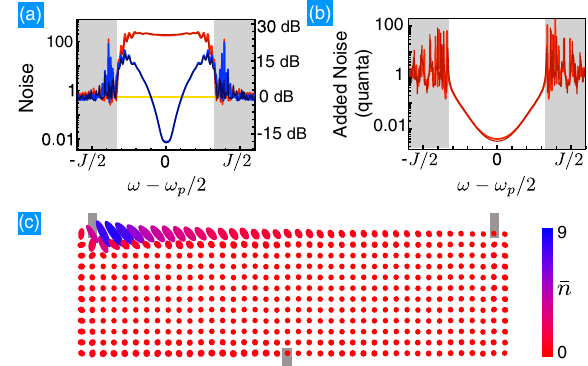
FIG. 4. Quantum stationary state and noise properties of the topological amplifier. (a) Noise spectral densities for both the amplified (red) and squeezed (blue) quadratures of the field leaving the output waveguide as a function of frequency, cf. Eq. (C9); the noise is plotted in units of quanta (left-hand axis), and also in decibels relative to the vacuum noise level (right-hand axis). The field leaking out of the output waveguide [top left corner in (c)] is strongly squeezed. We plot results for both a disordered system (light thick lines) and a clean sample (dark thin lines). The noise in the amplified quadrature is only slightly larger than the quantum-limit value for a phase- preserving amplifier (i.e., the amplified vacuum noise from the input port). The added noise in the amplified quadrature [in units ofquanta;cf.Eq.(C10))]forbothadisorderedandacleansampleis shown in (b). (c) Ellipses representing the Gaussian Wigner function of state of each site inside the cavity array [cf. Eq. (C11)]. In the bulk, the ellipses have a circular shape and their area is as small as allowed by the Heisenberg principle, representing a standard vacuum state. In contrast, the ellipses at the edge are anisotropic and have areas larger than the minimum required by the uncertainty principle, implying that one has a thermal squeezed state. This excess noise does not come from a finite temperature of the environment, but rather by the amplification of the zero-point fluctuations (quantum heating). Plotted as a color code is also the average number of photons on each site. The gray bars indicate the sites that are attached to coupling waveguides. Parameters are 40 × 12 sites, ω 2 . 14 J , Φ ¼ π = 2 , ν ¼ 0 . 08 J , k 2 . 2 , 0 ¼ p ¼ dered simulations the offset energies δω j are random numbers in the interval − 0 . 1 J < δω j < 0 . 1 J . For all plots, there is only vacuum noise entering from each